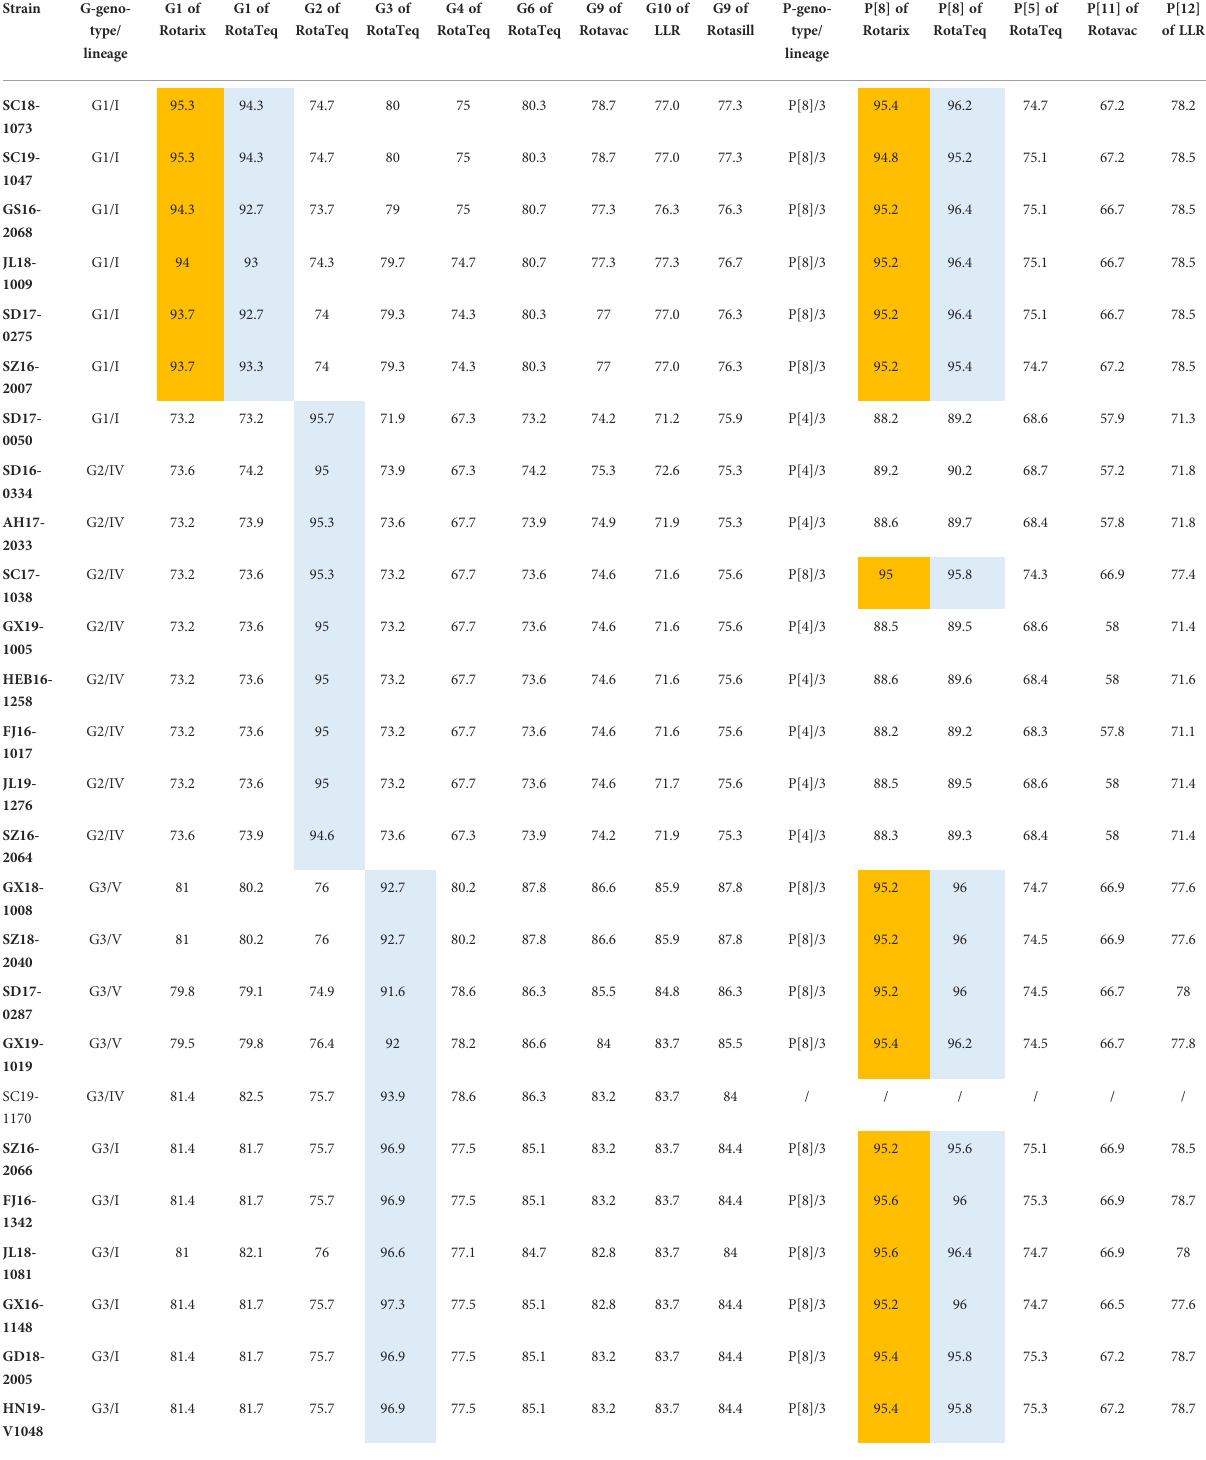
TABLE 2 Distance matrix for VP7 and VP4 based on amino acid identities. Strain G-geno-